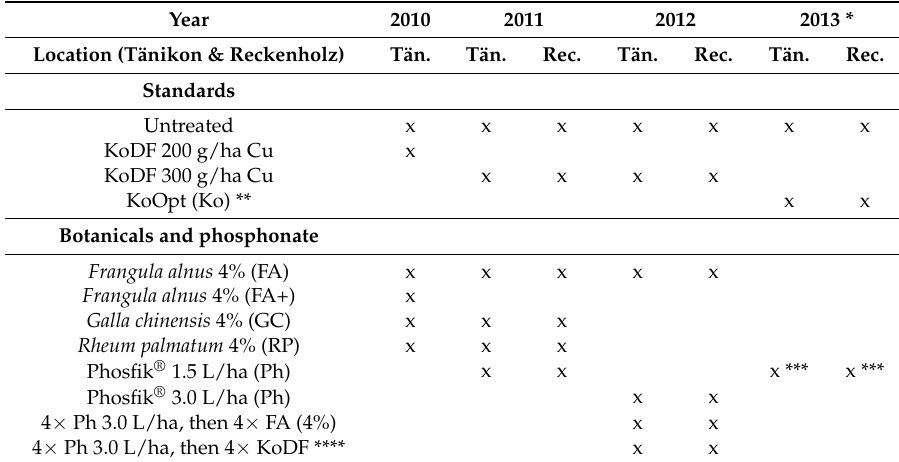
Table 2. Overview of the standard treatments, the botanicals and the antifungal agents applied in the field experiments from 2010 to 2013 (number of applications is described in Table